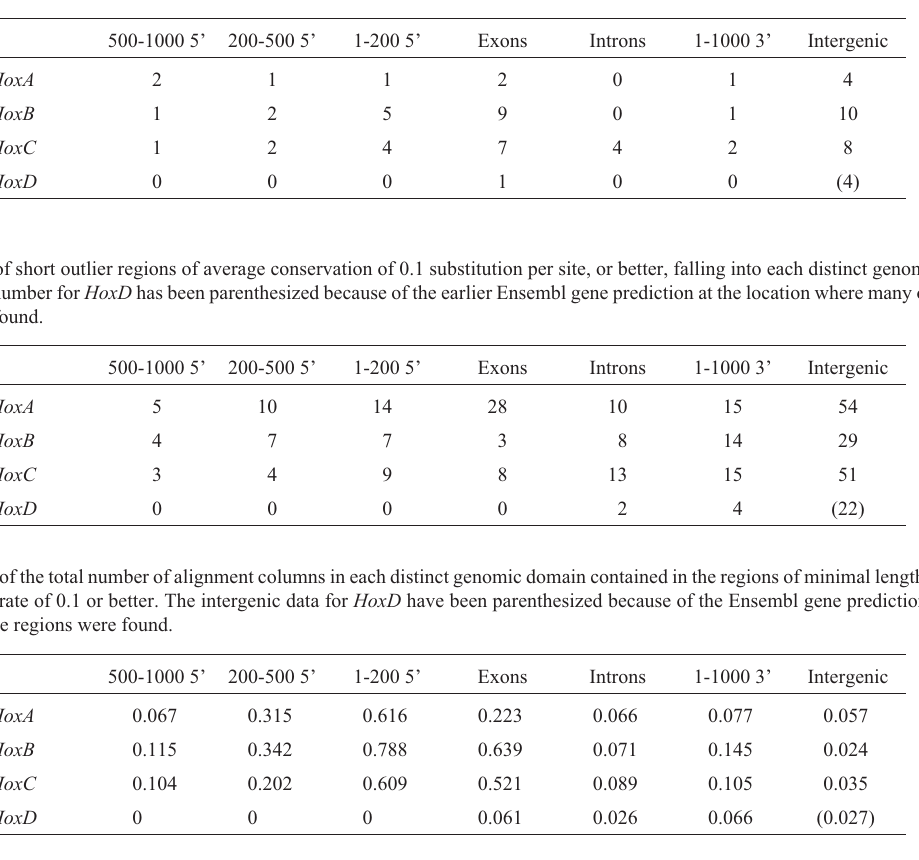
Table 1 - Number of long regions of average conservation of 0.1 substitution per site, or better, falling into each distinct genomic domain. The intergenic domain number for HoxD has been parenthesized because of the earlier Ensembl gene prediction at the location where many of the conserved regions have been found.